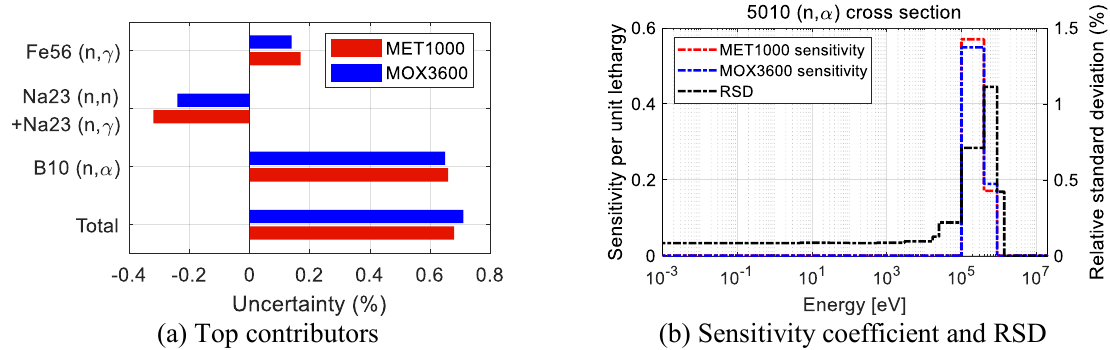
Figure 12. Uncertainty contributions to 𝚺